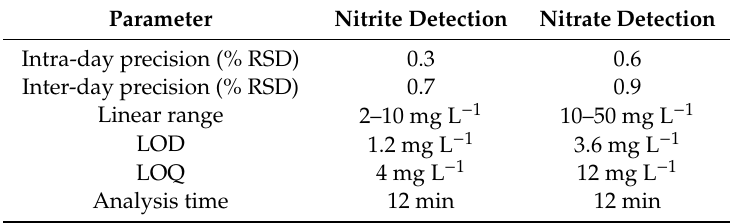
Table 1. The performance of µ PADs for simultaneous detection of nitrite and nitrate.